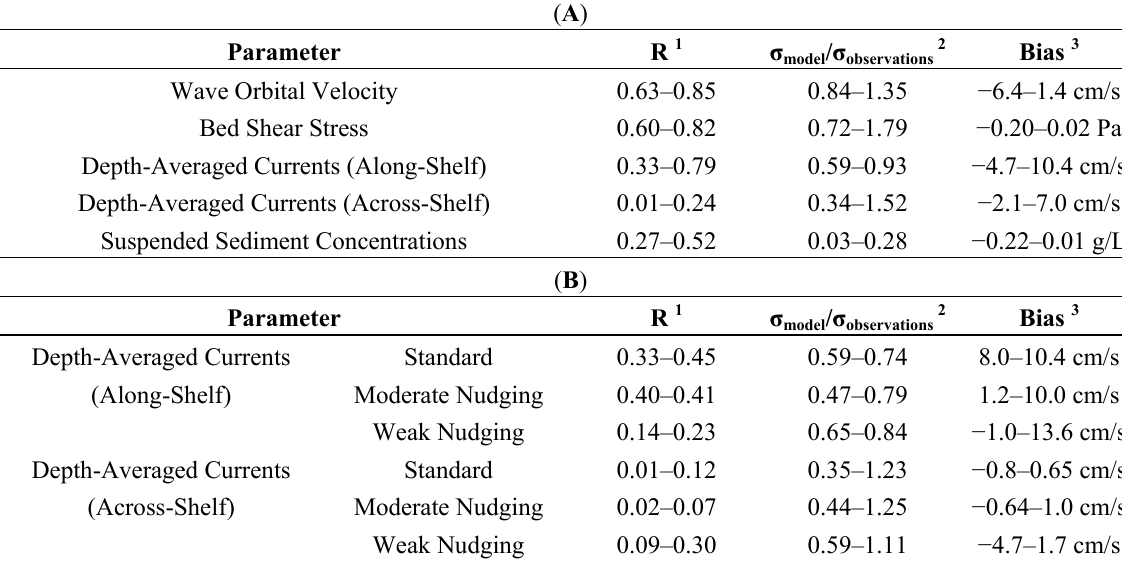
Table 5. Model evaluation statistics calculated ( A ) for the standard model for all tripod deployments with available observations; and ( B ) for depth-averaged currents from all three tripods’ first deployments for all nesting sensitivity tests. This was the only time period when all models ran